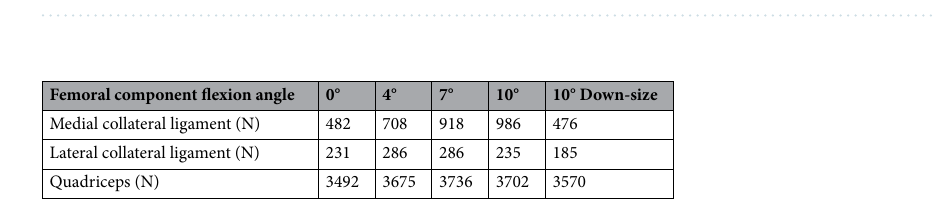
Table 3. Peak ligament force of each ligament and quadriceps in Bi-Surface Knee.